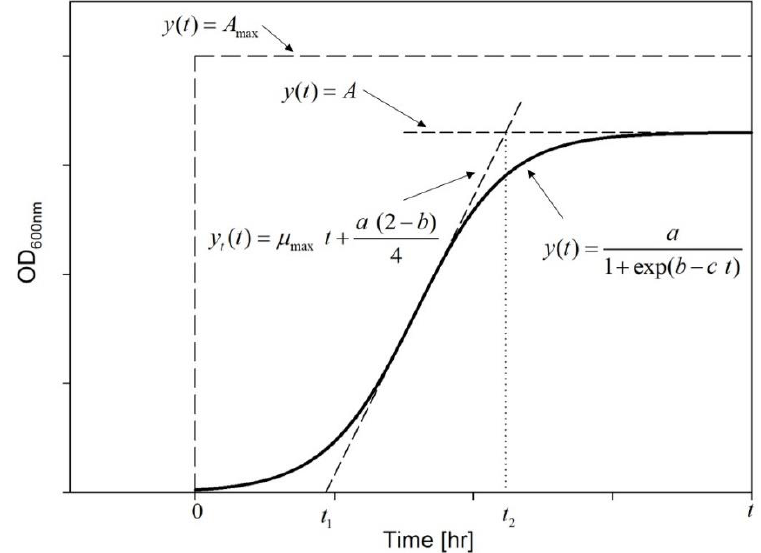
Figure 3. Schematic representation of the area under the growth curve together with the mathematical function describing boundary lines.